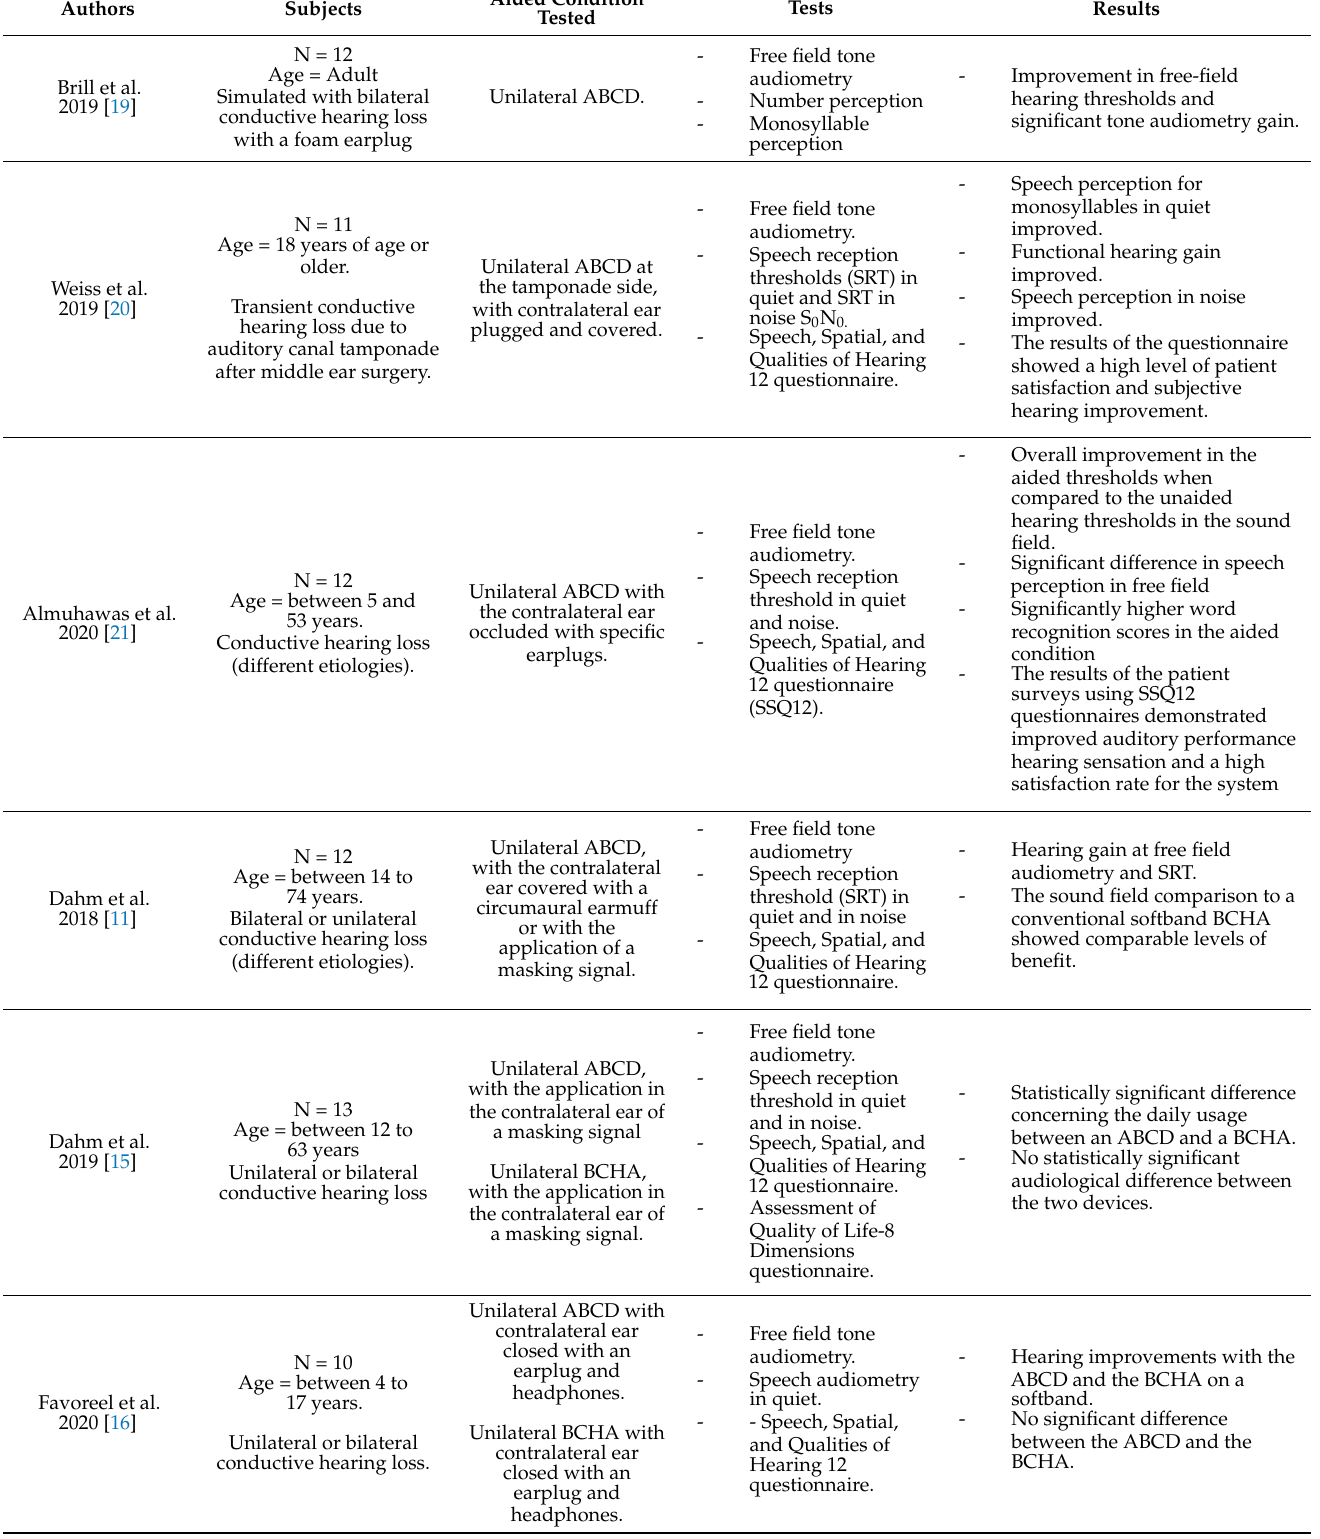
Table 3. Comprehensive review of the existing literature about